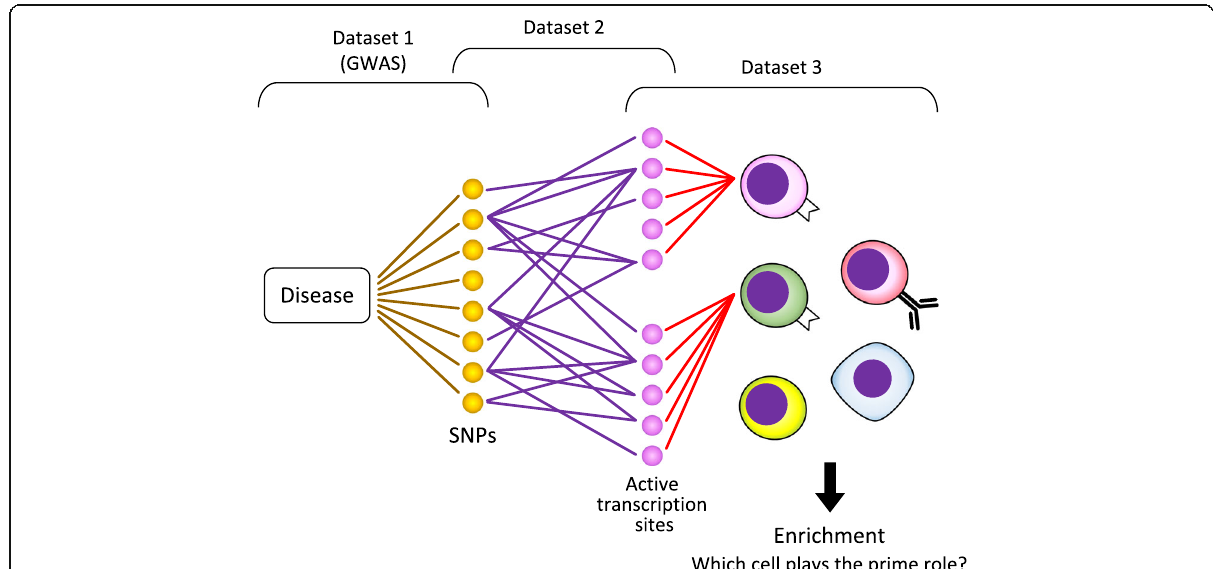
Fig. 3 Enhancer enrichment analysis searches for cell types that have “ enriched ” transcription sites genetically linked to a certain disease. Dataset 1: Associations between a disease and SNPs (GWAS). Dataset 2: Overlap between transcription sites. Dataset 3: Active transcription sites in each cell type